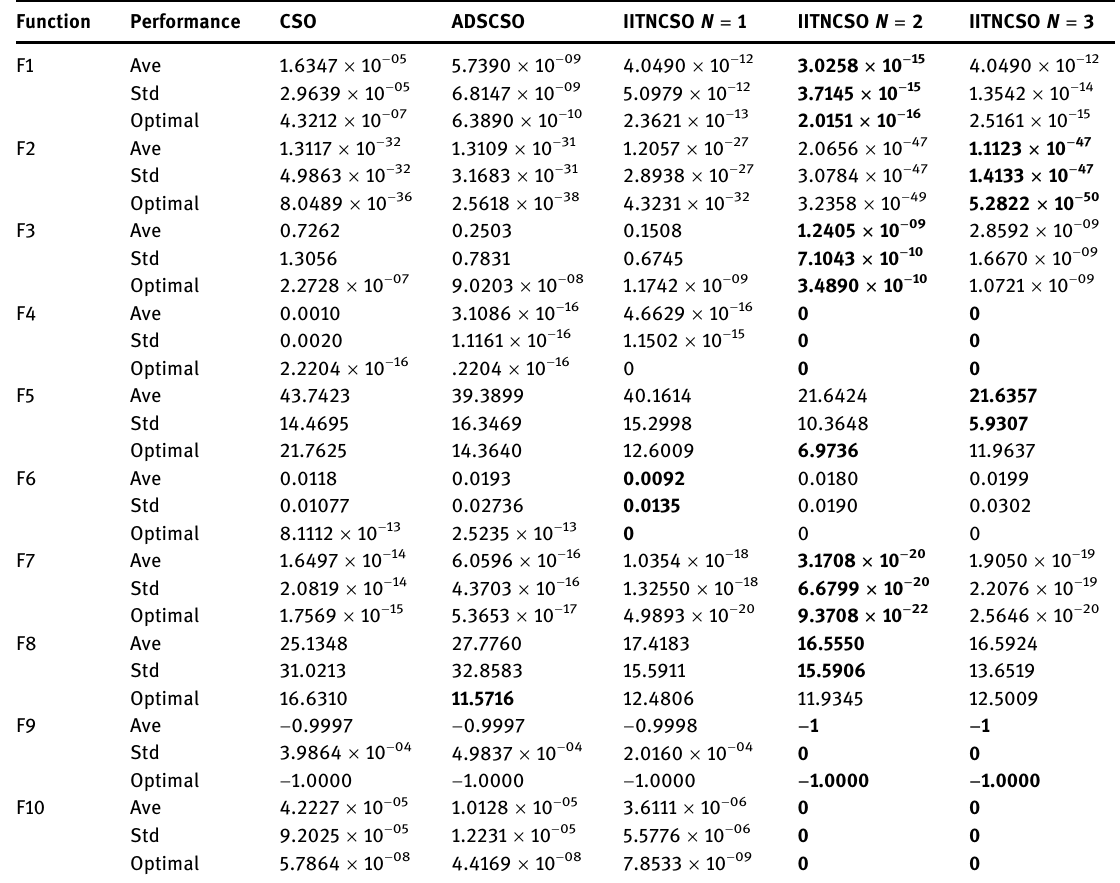
Table 3: Comparisons of CSO, ADSCSO, and